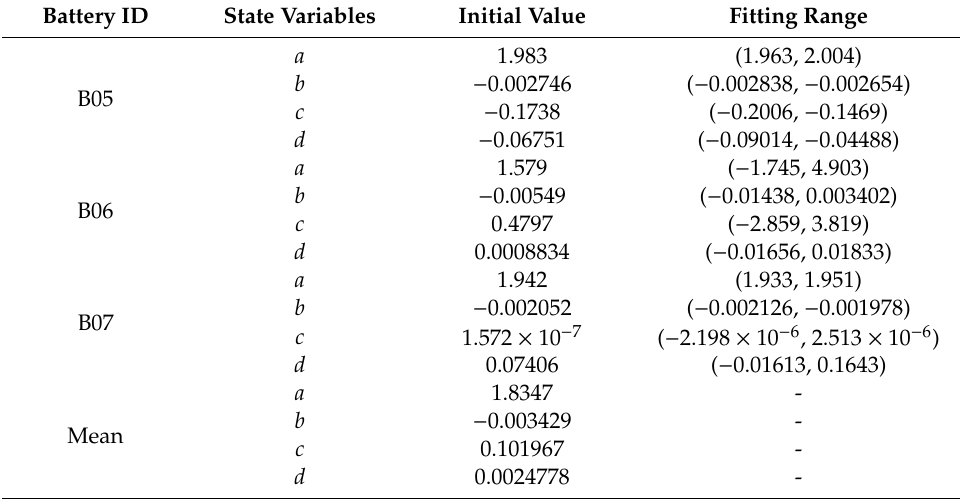
Figure 5. Degradation data and fitting curves of the four batteries: ( a ) B05; ( b ) B06; ( c ) B07; ( d ) B18. Table 2. Model Parameters of Batteries and State